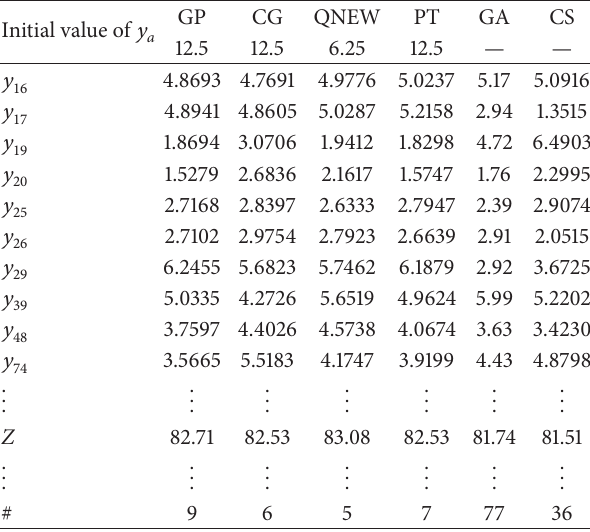
Table9:ComparisonofresultsfromsolvingtheSiouxFallsnetwork (continued).